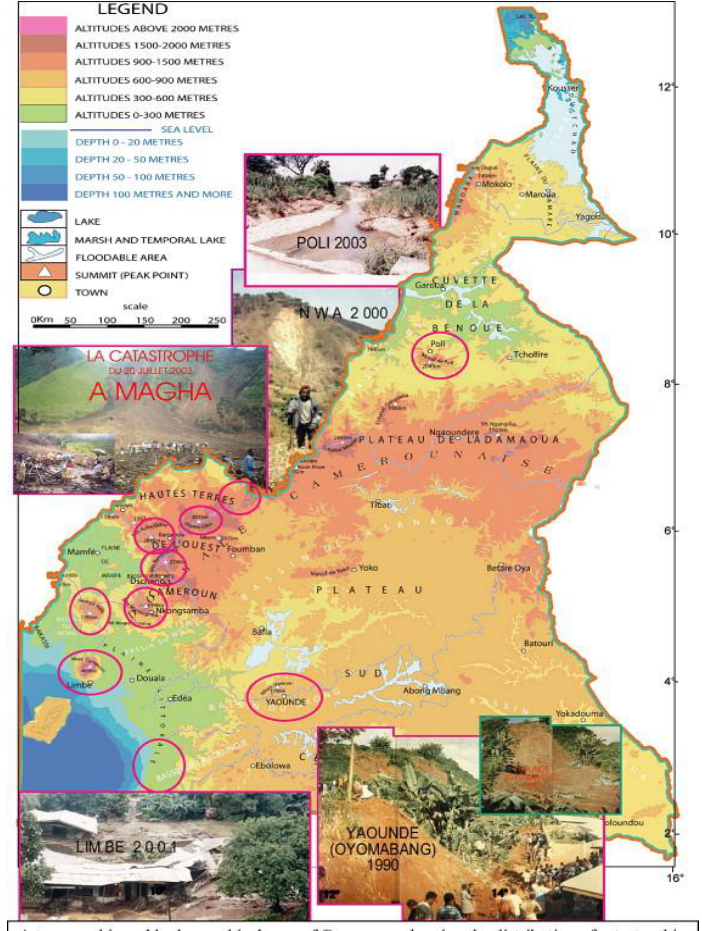
Figure 7. Topographic and hydrographic map of Cameroon showing the distribution of catastrophic landslides. Source: [79].